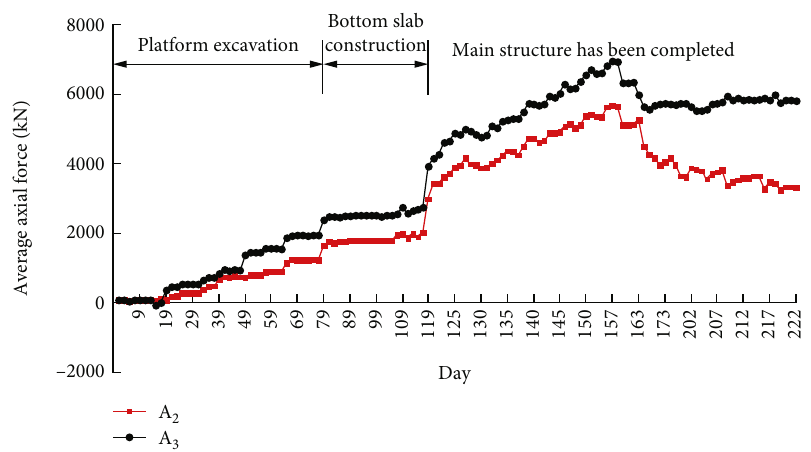
Figure 18: Time axis force curve at Beitaipingzhuang Station of Line 19.